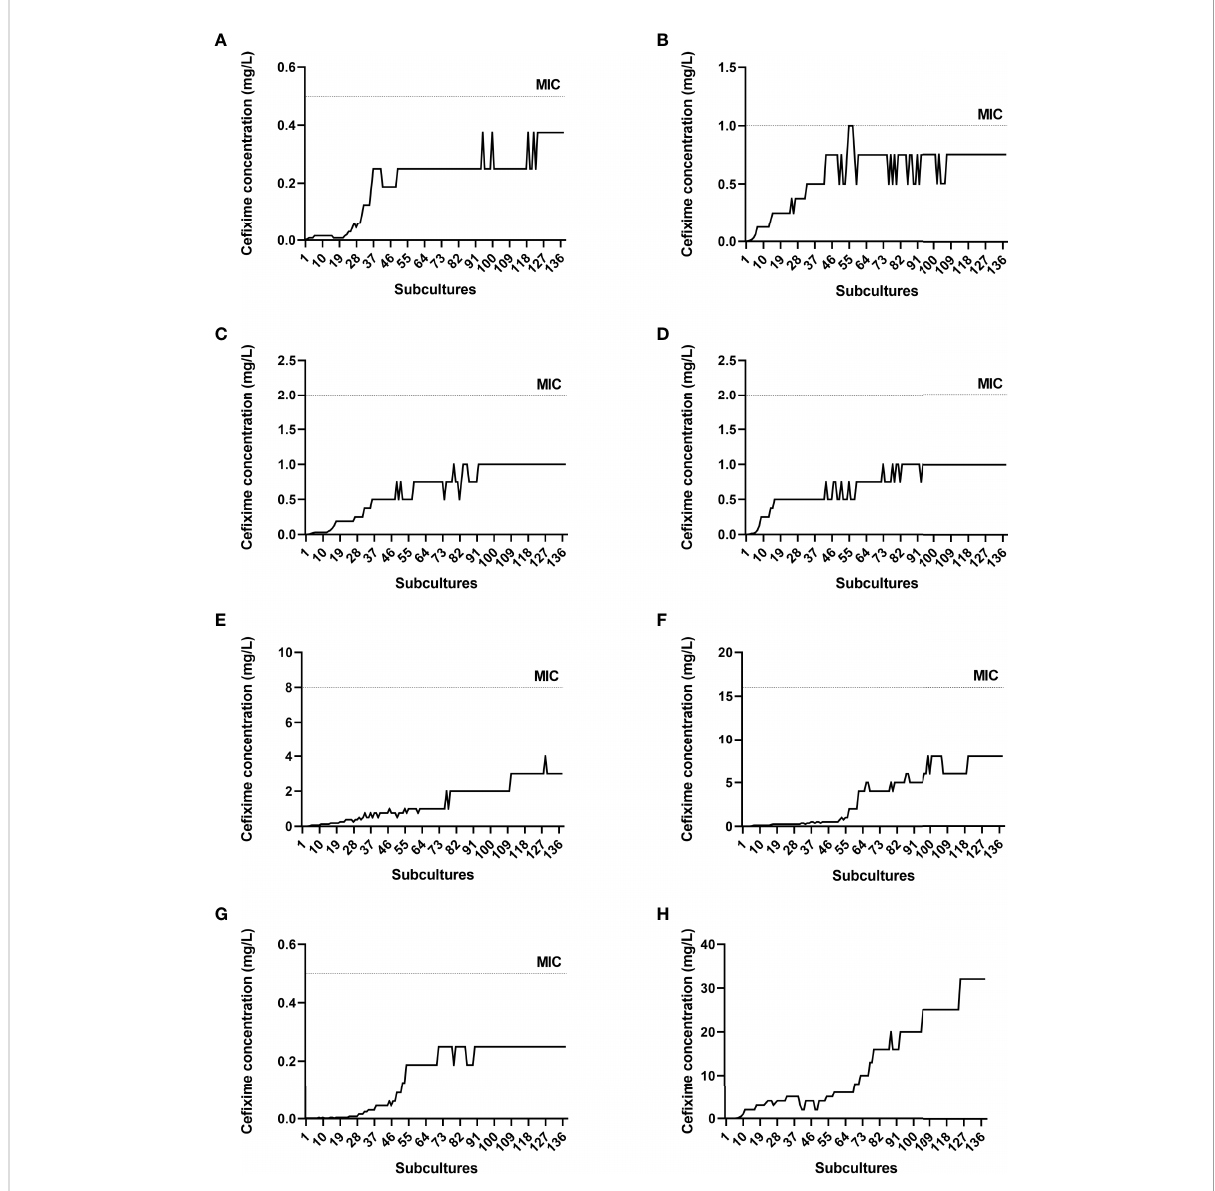
FIGURE 1 Progress curves during resistance evolution to ce fi xime. Dotted lines indicate minimum inhibitory concentration (MIC) values after induction. (A) M009, (B) M043, (C) M107, (D) M110, (E) M111, (F) M128, (G) WHO F, (H) WHO Y. The MIC for WHO Y is not shown (>32